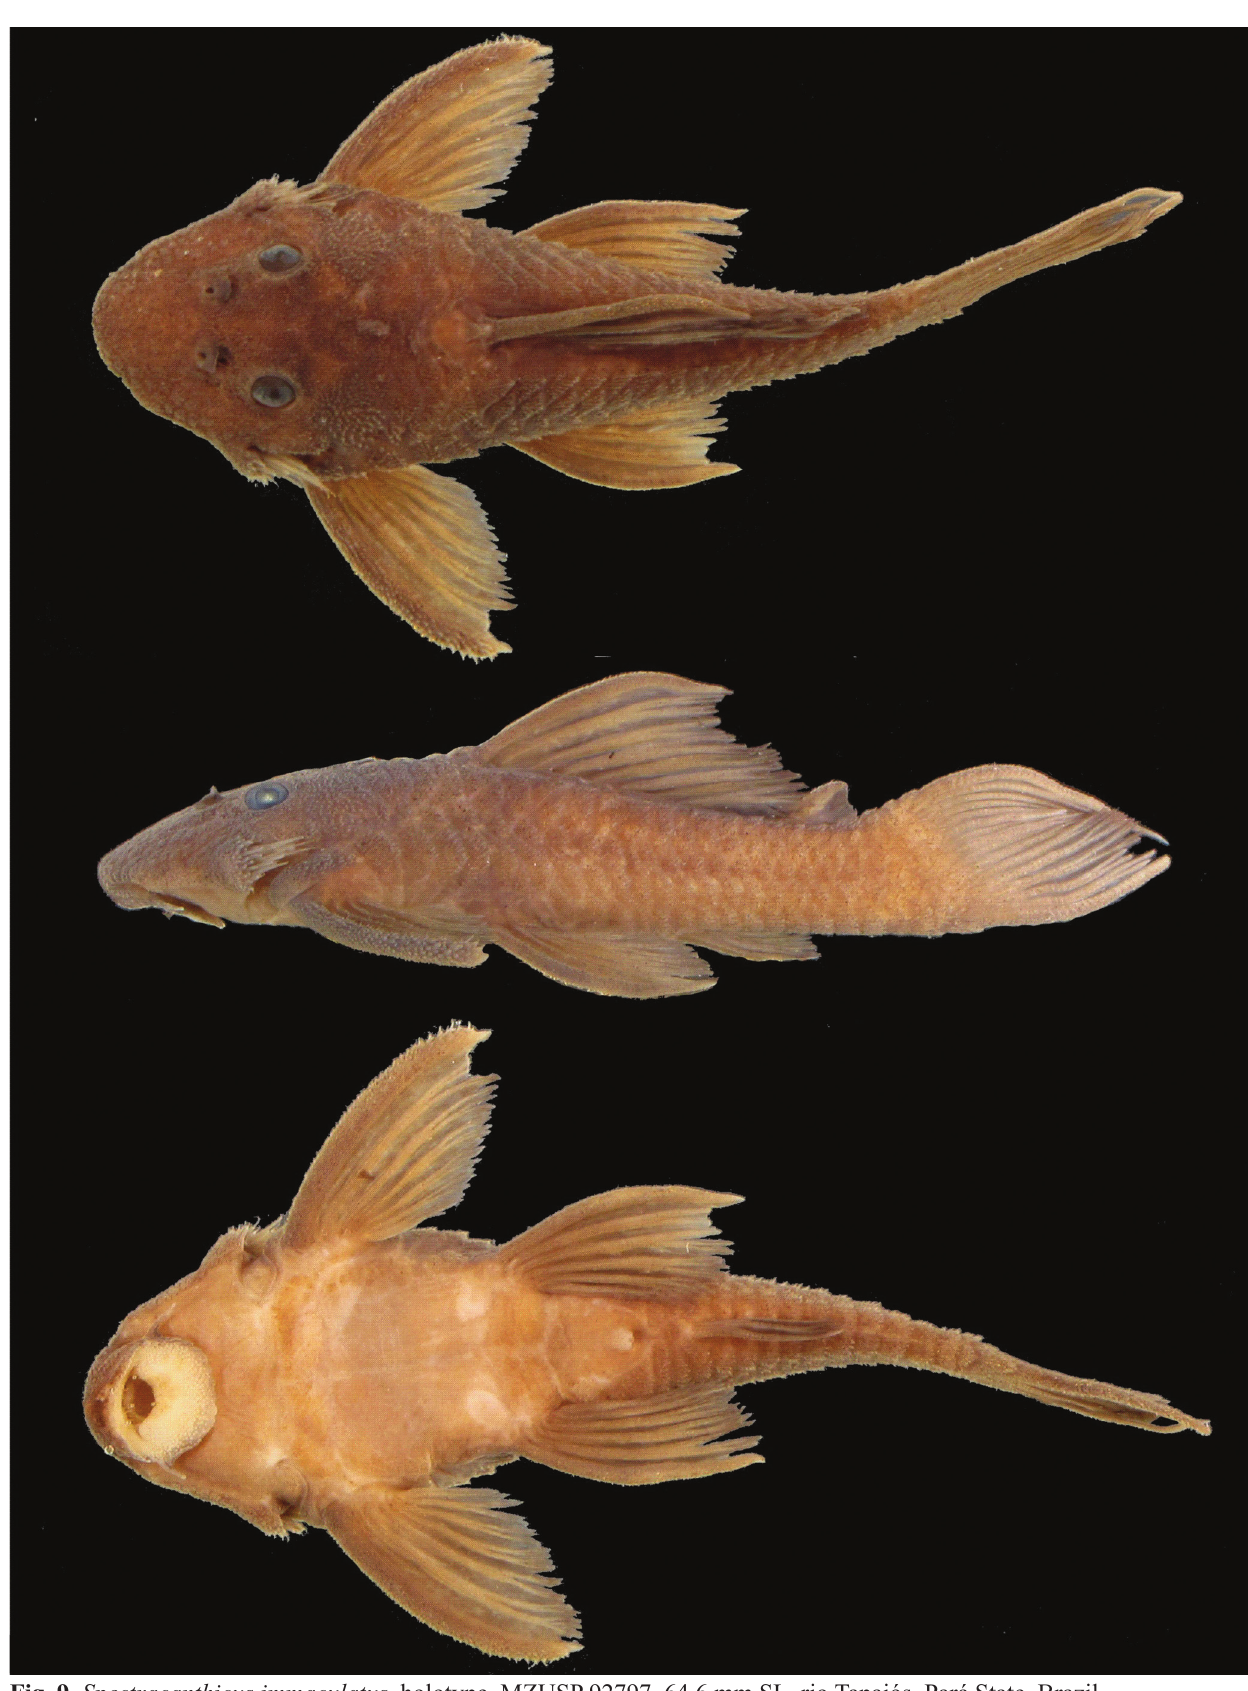
Fig. 9. Spectracanthicus immaculatus , holotype, MZUSP 92797, 64.6 mm SL, rio Tapajós, Pará State,